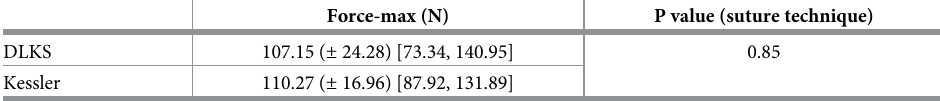
Table 2. Results of the ultimate load to failure testing (standard deviation) [minimum,